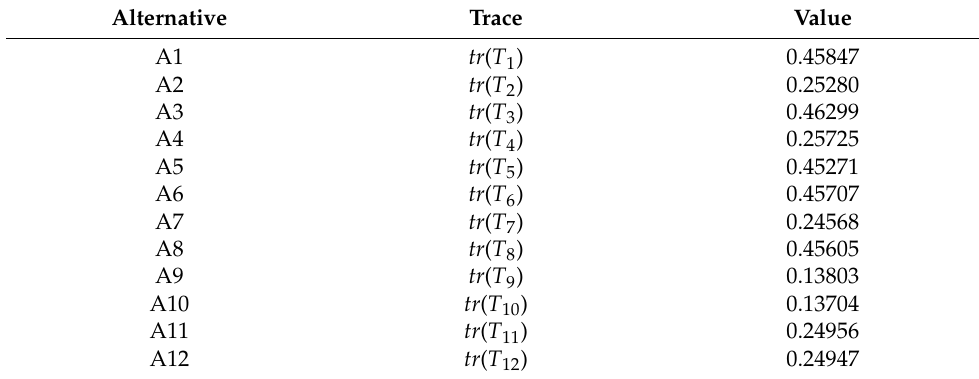
Table 17 represents the trace of the matrix T 1 , T 2 ,..., T 12 . Table 17. Trace of the matrix T 1 , T 2 ,..., T 12